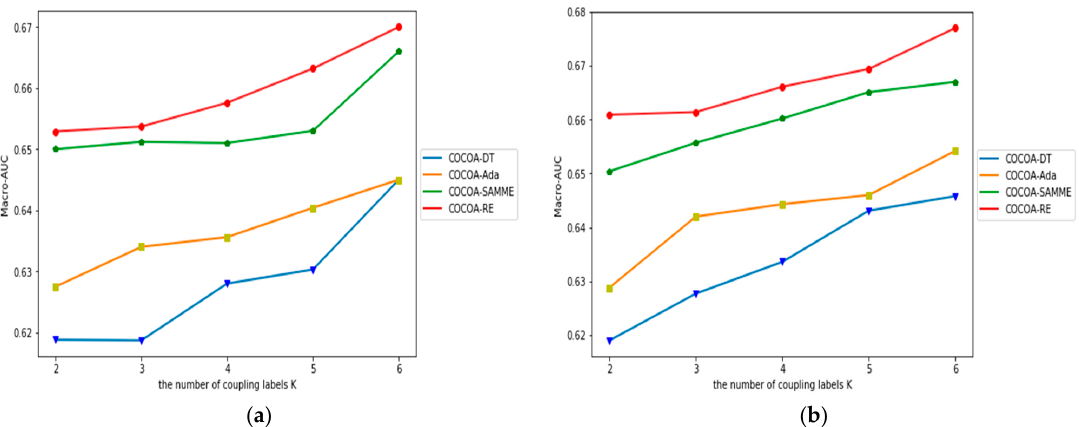
Figure 4. Comparative Macro-AUC values with changing coupling labels: ( a ) the Macro-AUC values of different K when the binary classifier is decision tree; ( b ) the Macro-AUC values of different K in the case when the binary classifier is neural network. AUC: area under the ROC curve.